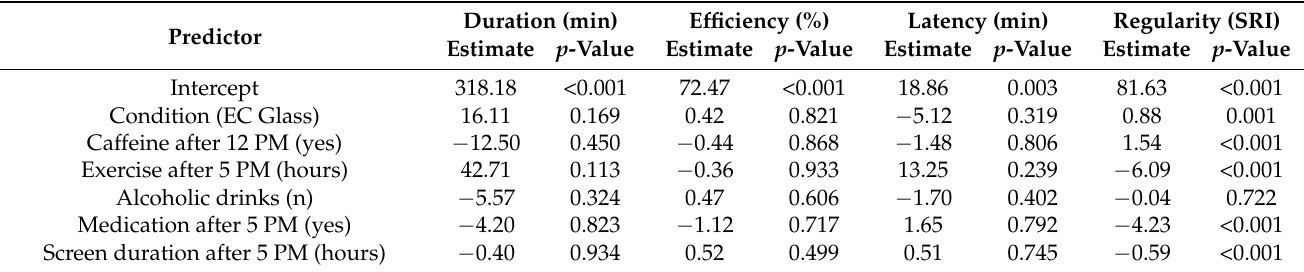
Table 4. Results of the linear mixed effects models for actigraph-measured sleep quality metrics between the two experi- mental conditions, controlling for lifestyle factors.